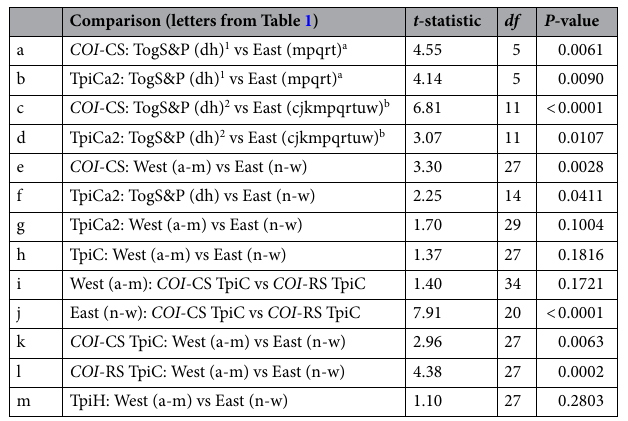
Table 2. Statistical comparisons between selected FAW collections using two-tailed t-test (TogS&P = Togo and São Tomé and Príncipe group). a Only collections from 2016 to 2017 16 . b Only collections from 2016 to 2017 26 .